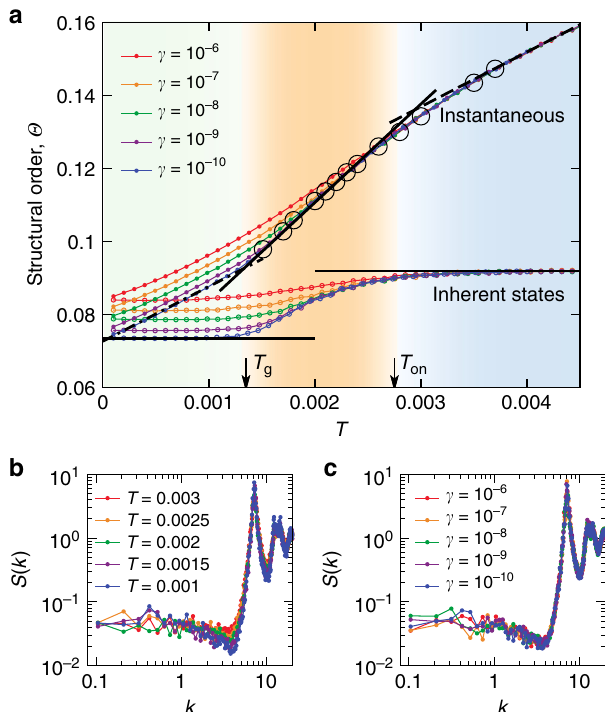
Fig. 1 Structure formation during cooling. a Evolution of structural order Θ in instantaneous ( fi lled circles) and inherent states (open circles) in a 2D PM ( Δ ¼ 13 % ). Dotted data are shown for different cooling rates γ . The ¼ 0 : 00276) and dynamical glass transition onset temperature ( T on temperature for the slowest cooling rate ( T g ¼ 0 : 00135) are indicated, allowing us to separate the simple-liquid (light blue), supercooled (orange), and glass regimes (light green) in a clear manner. For instantaneous states, the temperature dependence of Θ can be fi tted with a linear function in the supercooled regime ð Θ (cid:2) Θ 0 Þ = Θ 0 ¼ κ ð T (cid:2) T 0 Þ = T 0 (solid line), and changes the behaviour at lower (dash-dotted line) or higher temperatures (dashed line). The big open circles indicate equilibrium data from independent simulations. For inherent states, Θ stays constant in both simple-liquid and glass regimes (horizontal lines). Note that smaller Θ means higher order. See Table 1 for the fi tting parameters and Supplementary Table 1 for the other systems. b , c Static structure factor S ð k Þ for different temperatures at γ ¼ 10 (cid:2) 10 (panel b ) and different cooling rates at T ¼ 0 : 0015 (panel c ). The same colouring scheme in the background is also applied in Fig. 2, for the ease of visualising different temperature regimes. regimes are clearly identi fi ed, i.e., the high-temperature simple- liquid, supercooled, and low-temperature glass states, separated of the super-Arrhenius dynamics by the onset temperature T on (Supplementary Fig. 3) and the dynamical glass transition tem- (where the system falls out of equilibrium upon perature T g cooling). For inherent states, we see no change in the structure in the simple-liquid and glass regimes. It is consistent with the physical picture that the system gets in fl uenced by the underlying PEL only below T , and fi nally trapped in the basins (metastable on 3,35 . Accordingly, in states) after a dynamical glass transition at T g the simple-liquid and glass regimes, the evolution of Θ in instantaneous states is a pure consequence of thermal fl uctuations controlled by temperature. Only in the supercooled regime, the glassy structural order grows, leading to a non-trivial linear scaling relation between Θ and T :